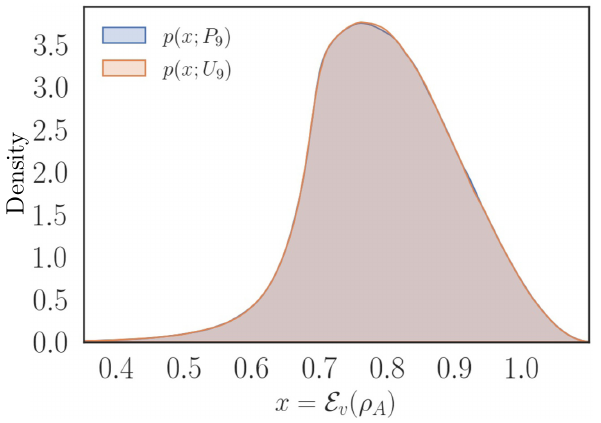
FIG. 7. The two-qutrit case d 2 = 9. The distributions p ( x ; U ) of entanglement obtained from the action of 9 × 9 unitaries U on Haar-distributed product states. Two distributions, one corre- sponding to the 2-unitary permutation matrix P 9 , Eq. (77) and the other a 2-unitary U 9 obtained from the map with a random seed, are shown. These two are numerically indistinguishable and we cannot find a different distribution than the one shown here for the O ( 10 3 ) 2-unitaries obtained from the